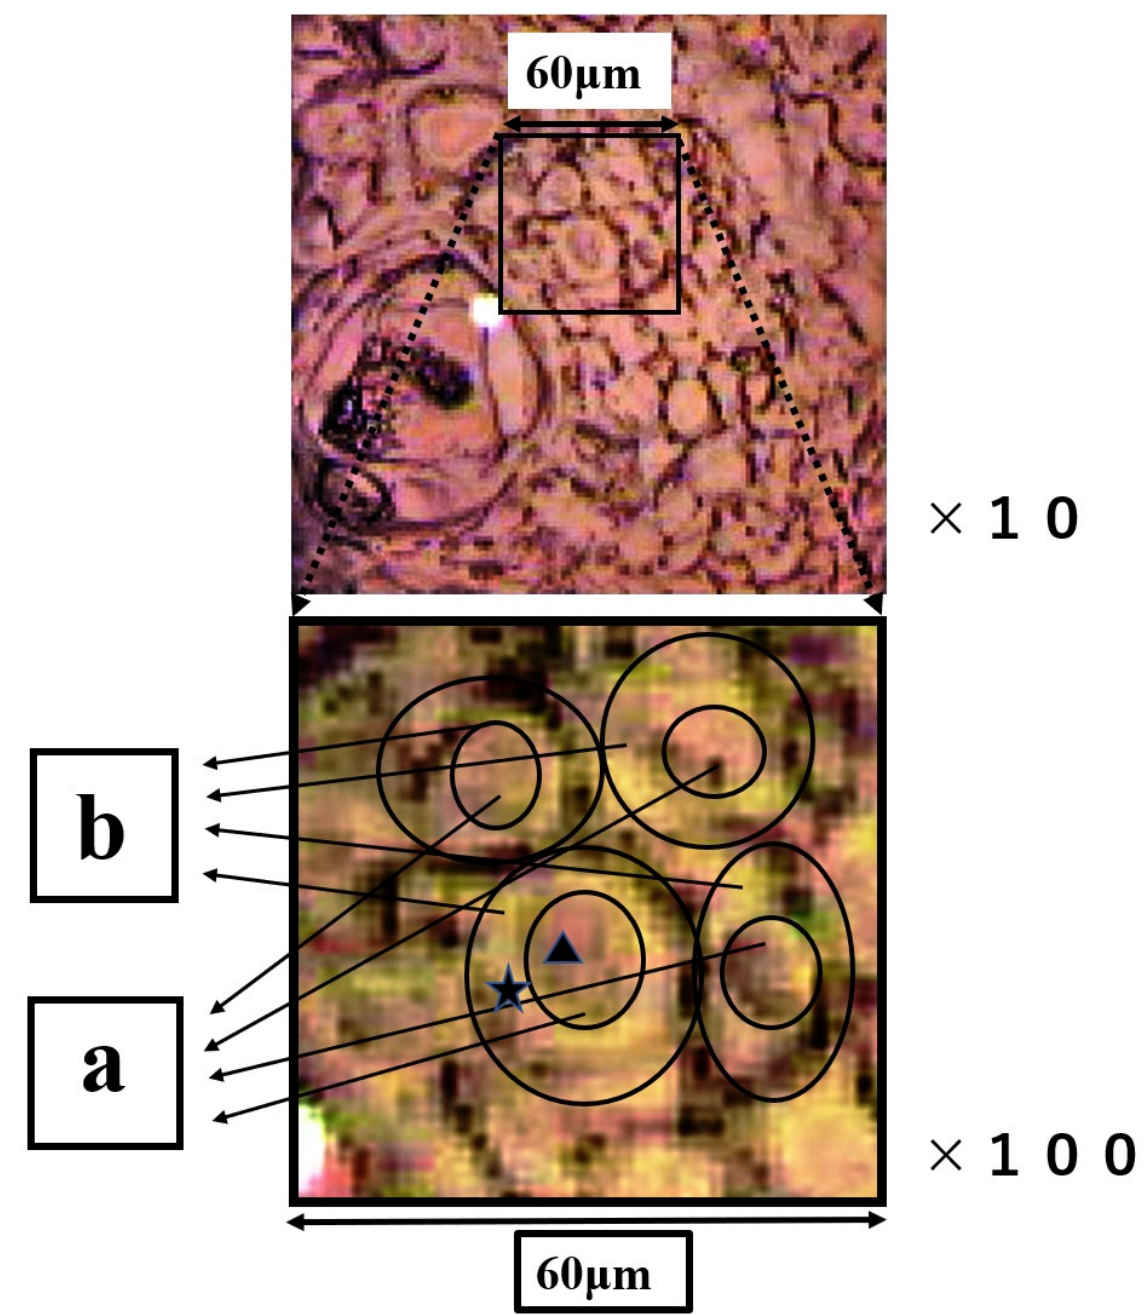
Figure 4. The upper image is the CCD camera (equipped with Raman micro-spectroscope) image on the gold-covered slide glass. The images below are the enlarged images of the four-sided area. In the figure below, the outline of the nucleus and cytoplasm is illustrated, and ▲ and ★ indicate the nucleus and ★ the cytoplasm individually. Region ( a ) is nucleus and region ( b ) is cytoplasm.